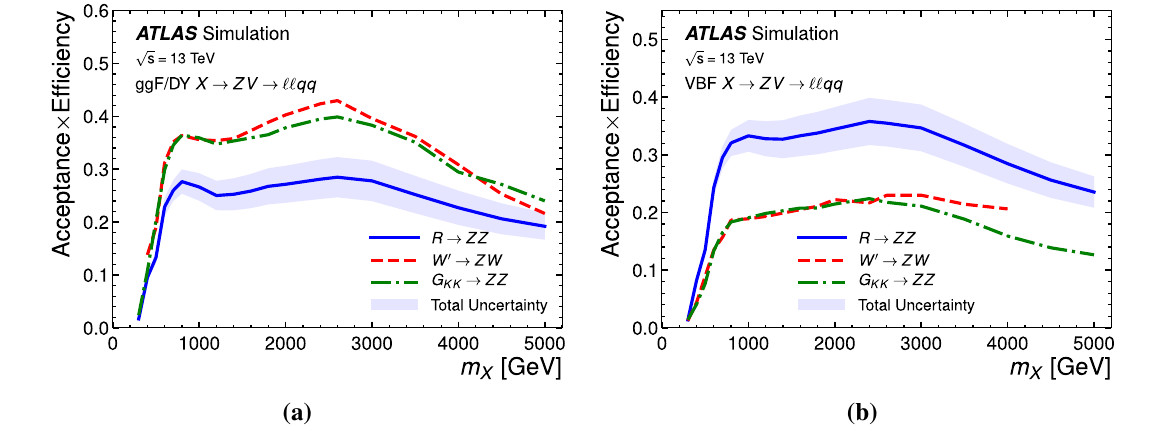
Fig. 8 Selection acceptance times efficiency for the X → ZV → (cid:4)(cid:4) qq signal events from MC simulations as a function of the resonance mass for a ggF/DY and b VBF production, combining all SRs of both the resolved and merged analyses. The light shaded band represents the total statistical and systematic uncertainties for the RS radion model,